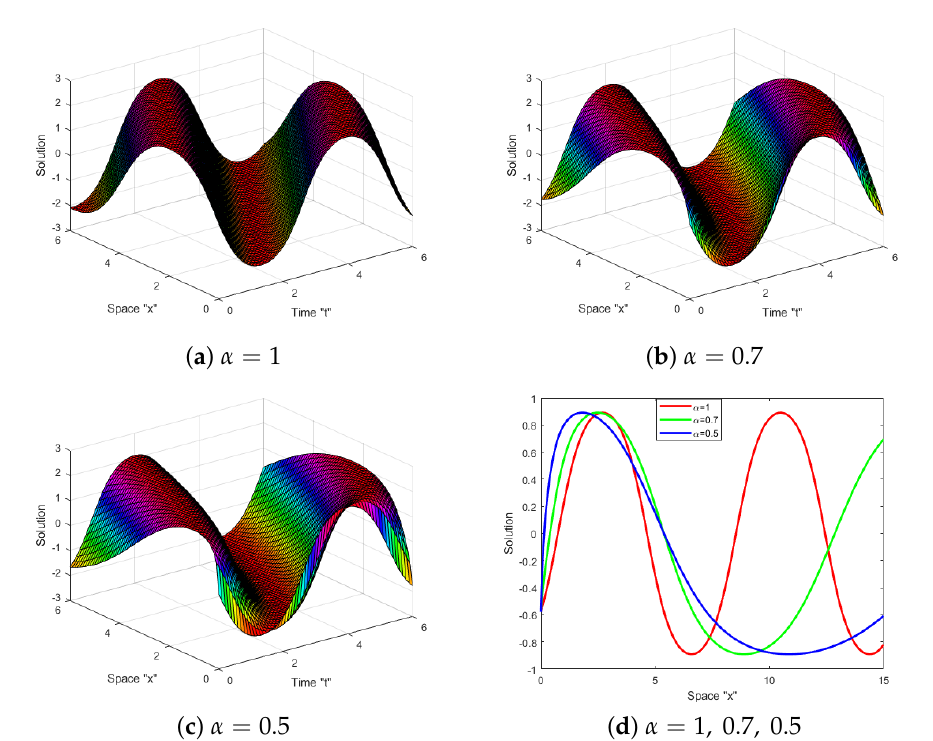
Figure 1. ( a – c ) show the 3D profiles of Equation (16) with σ = 0, c 0 = 3, and different values of α . ( d ) denotes the 2D profile of Equation